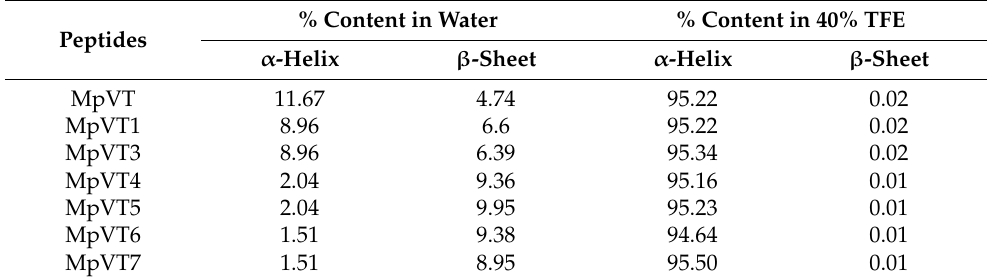
Table 2. Calculated percentage of helicity for MpVT and its analogs under differences conditions a .